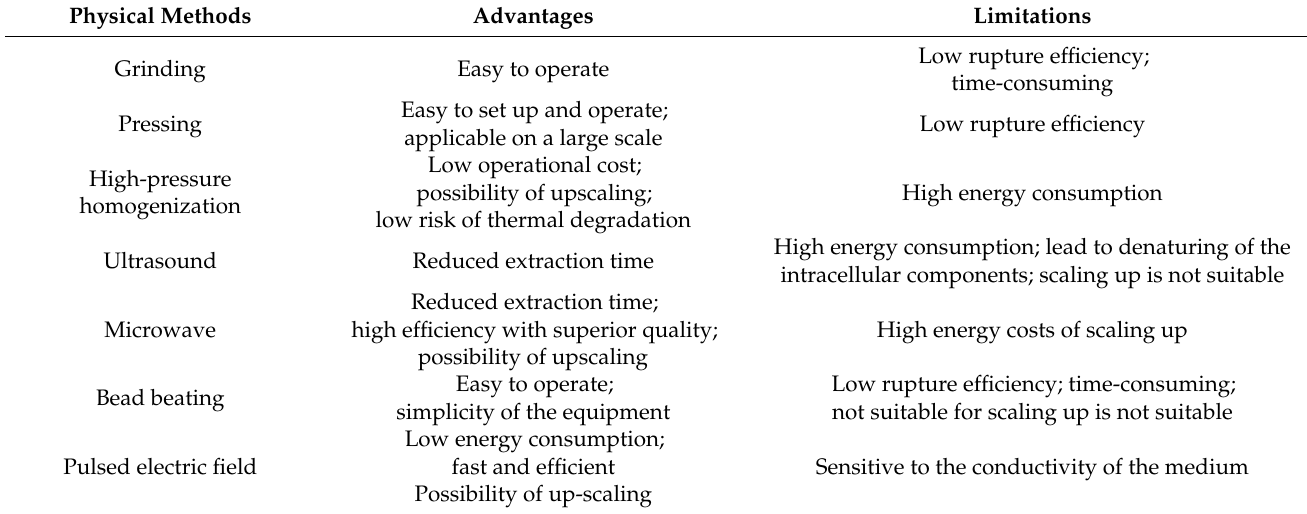
Table 4. The advantages and limitations of different physical